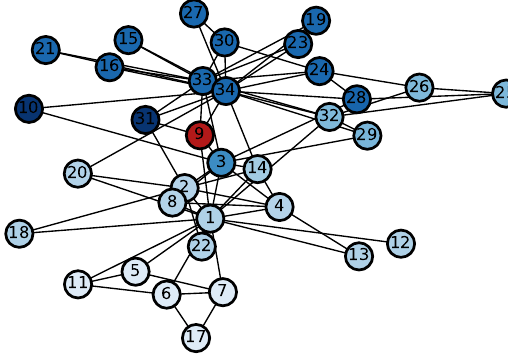
( e ) Inclusion probability in the local community of vertex 9 Figure 7. Inclusion probabilities in the local communities starting from five different seeds. Darker color indicates a higher inclusion probability. ( a ): vertex 1 (instructor); ( b ): vertex 34 (administrator); ( c ): vertex 8; ( d ): vertex 25; ( e ): vertex 9. Seed vertices are in